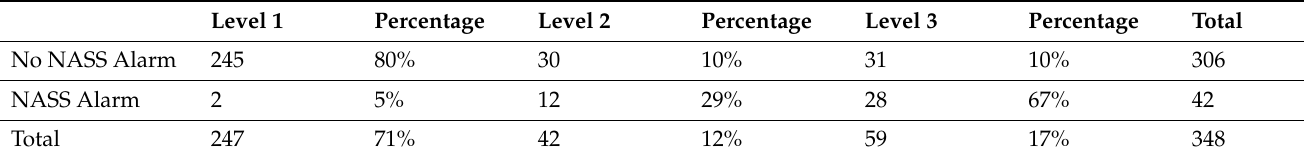
Table 1. Number of a NASS heat/cold exposure CPC statistical alarms by whether at least one region experiencing PHE Heat Health and Cold Weather